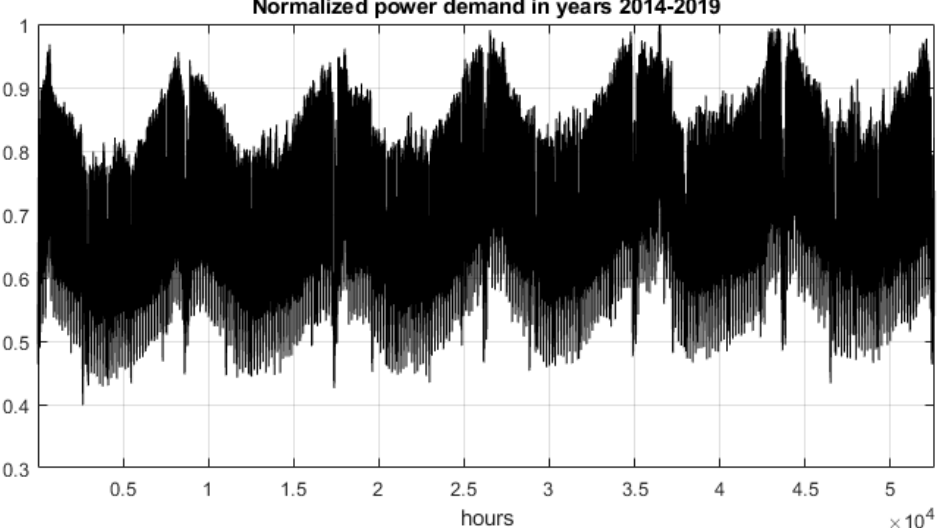
Figure 2. Normalized power demand in the PPS in the investigated period of 2014–2019.